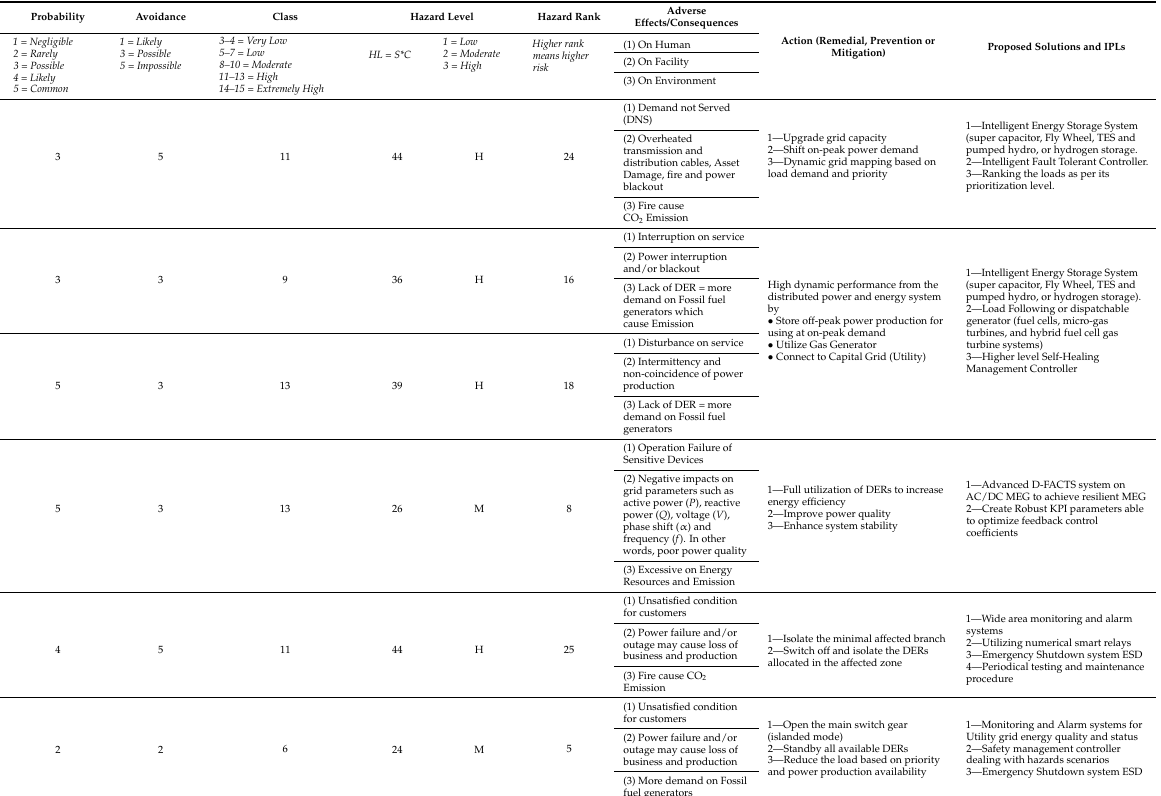
Table 1. Excerpt list of hazards in